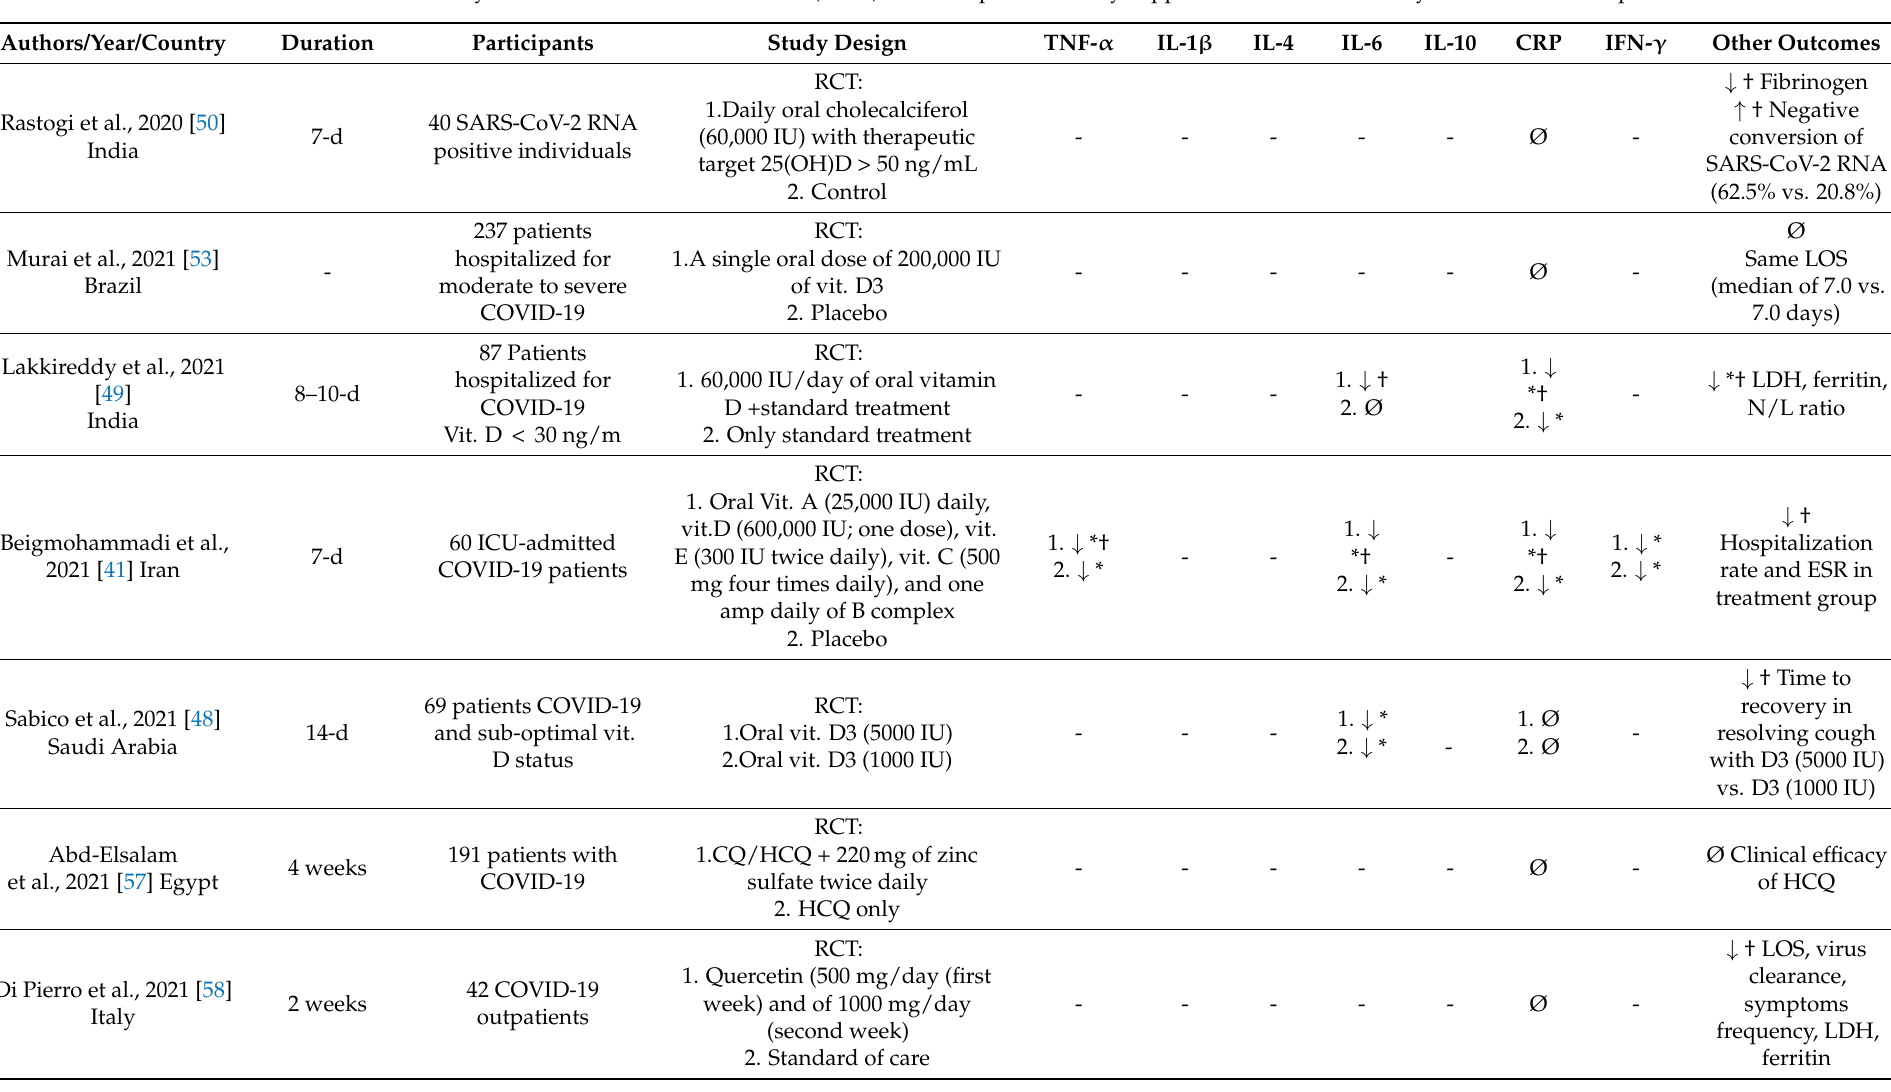
Table 1. Summary of Randomized controlled trials (RCTs) on the impact of dietary supplements on inflammatory markers and in response to